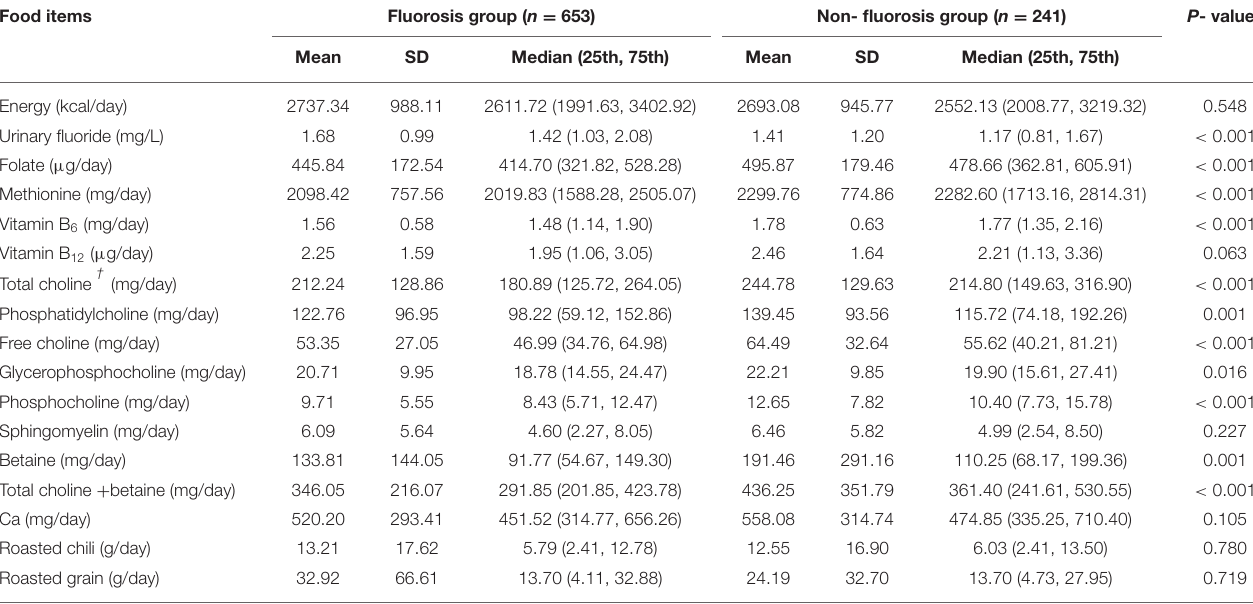
TABLE 2 | Comparison of energy, urinary fluoride, folate, methionine, vitamins B 6 and B 12 , total choline, betaine, and individual choline-containing compounds intake ‡ between fluorosis and non-fluorosis. Food